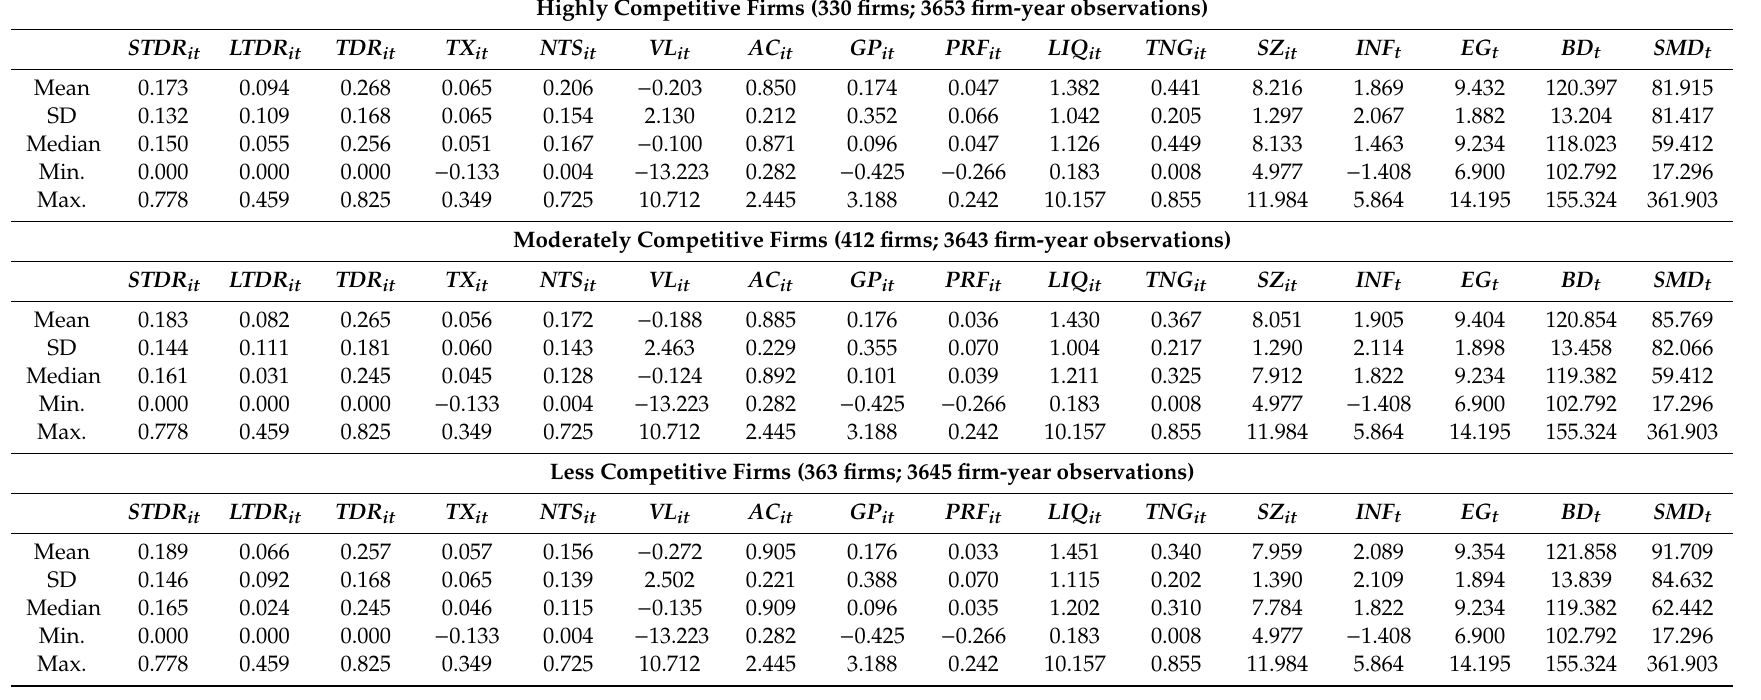
Table 3. Descriptive statistics of sample